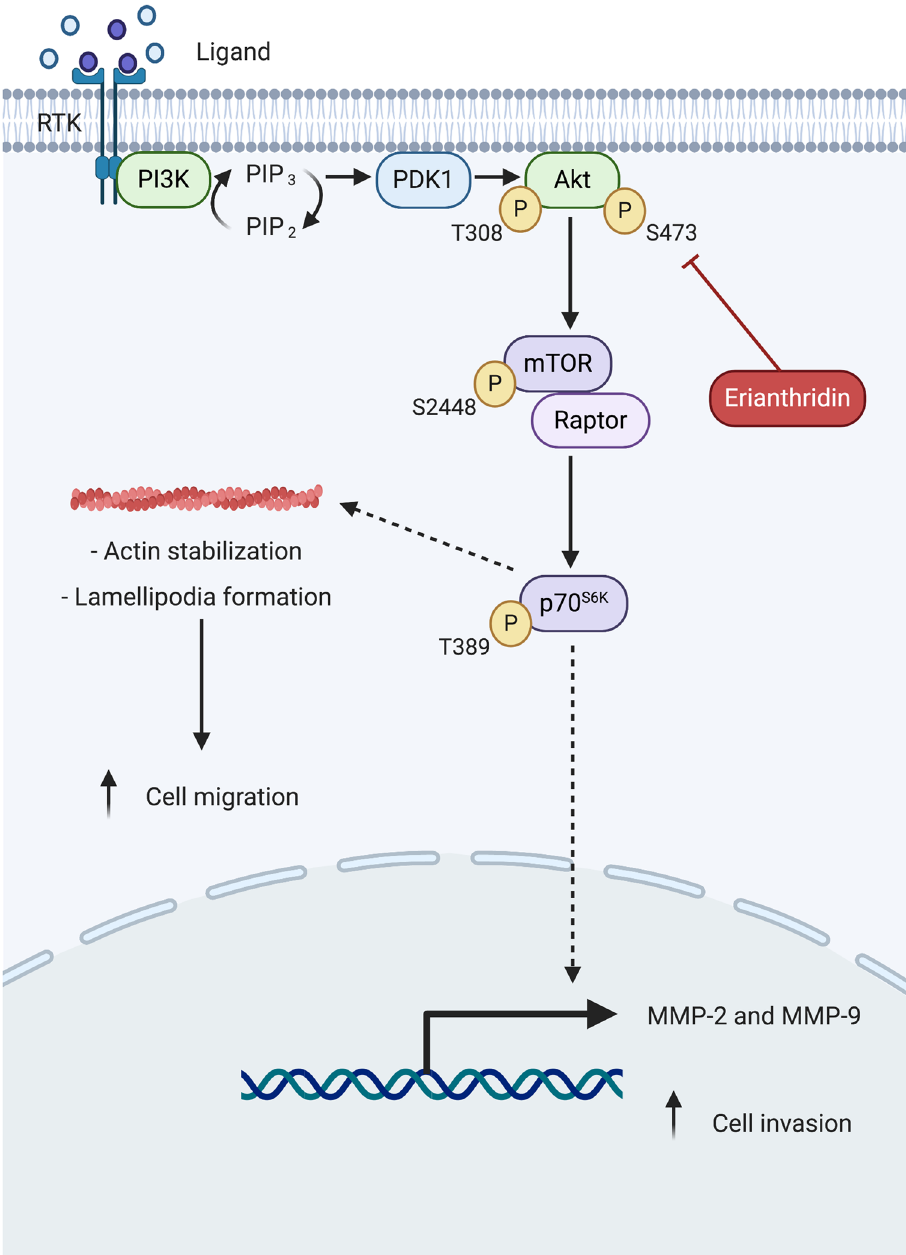
Figure 7. A Scheme diagram of this study. ETD suppresses lung cancer cell migration and invasion through inhibition of Akt/mTOR/p-p70 S6K signaling pathway. This diagram was created with